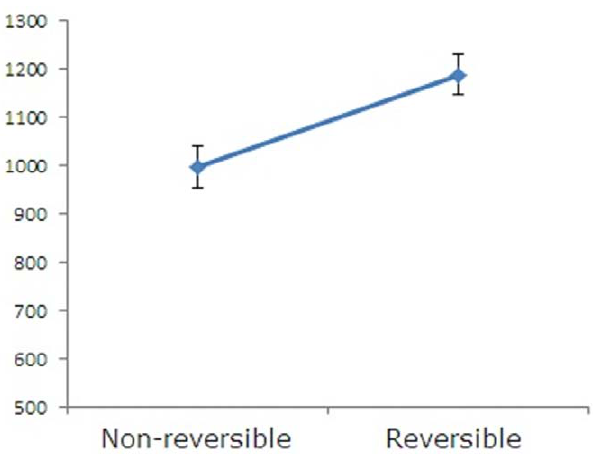
Figure 1. Reading times at the second argument position. Mean reading times for the second argument between the reversible scrambled sentence and the non-reversible scrambled sentence conditions. Error bar denotes standard mean error.